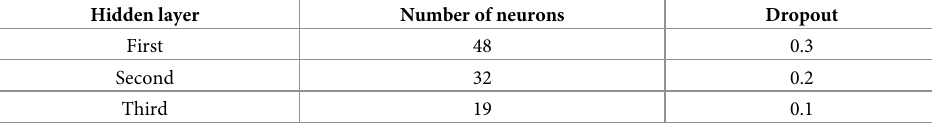
Table 2. The numbers of neurons and values of dropouts in the hidden layers of the ANN models. Hidden